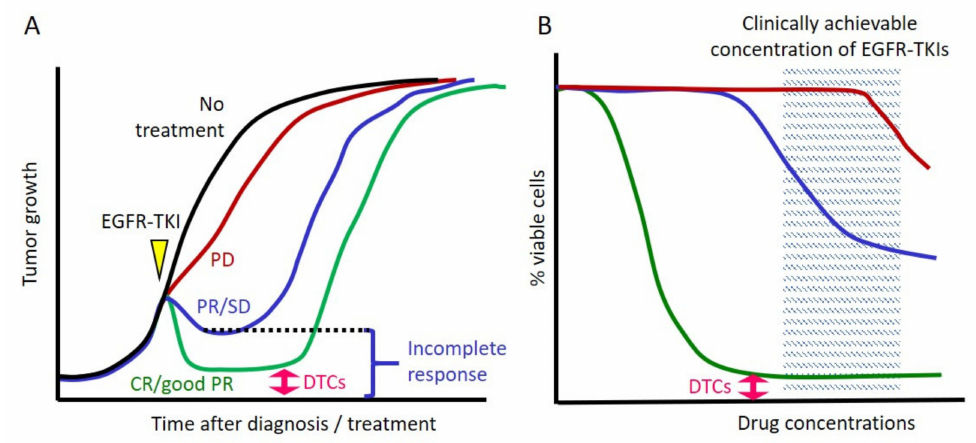
Figure 1. Clinical responses to EGFR TKIs and their corresponding in vitro growth-inhibitory curves. ( A ) EGFR -mutated lung cancer patients demonstrate different responses to an EGFR TKI as follows: complete response (CR), partial response (PR), stable disease (SD), and progressive disease (PD). Even in patients who experience a CR or a relatively strong PR, disease recurrence with the acquisition of resistance is inevitable; therefore, it is hypothesized that a small number of viable cells (drug-tolerant cells (DTCs)) remain during the period of maximum response. The yellow triangle indicates the initiation of EGFR TKI therapy. ( B ) In vitro cell line models are useful to mimic clinical responses to EGFR TKIs. Green: cell lines with the highest sensitivities; blue: those with moderate sensitivities; and red: those with inherent resistance. Each line of the growth-inhibitory curve corresponds to the clinical response drawn in the same color in Figure 1A. A small fraction of surviving cells remains even in cell lines with the highest sensitivity to EGFR TKIs (green line), and these remaining cells are often used as an in vitro model of